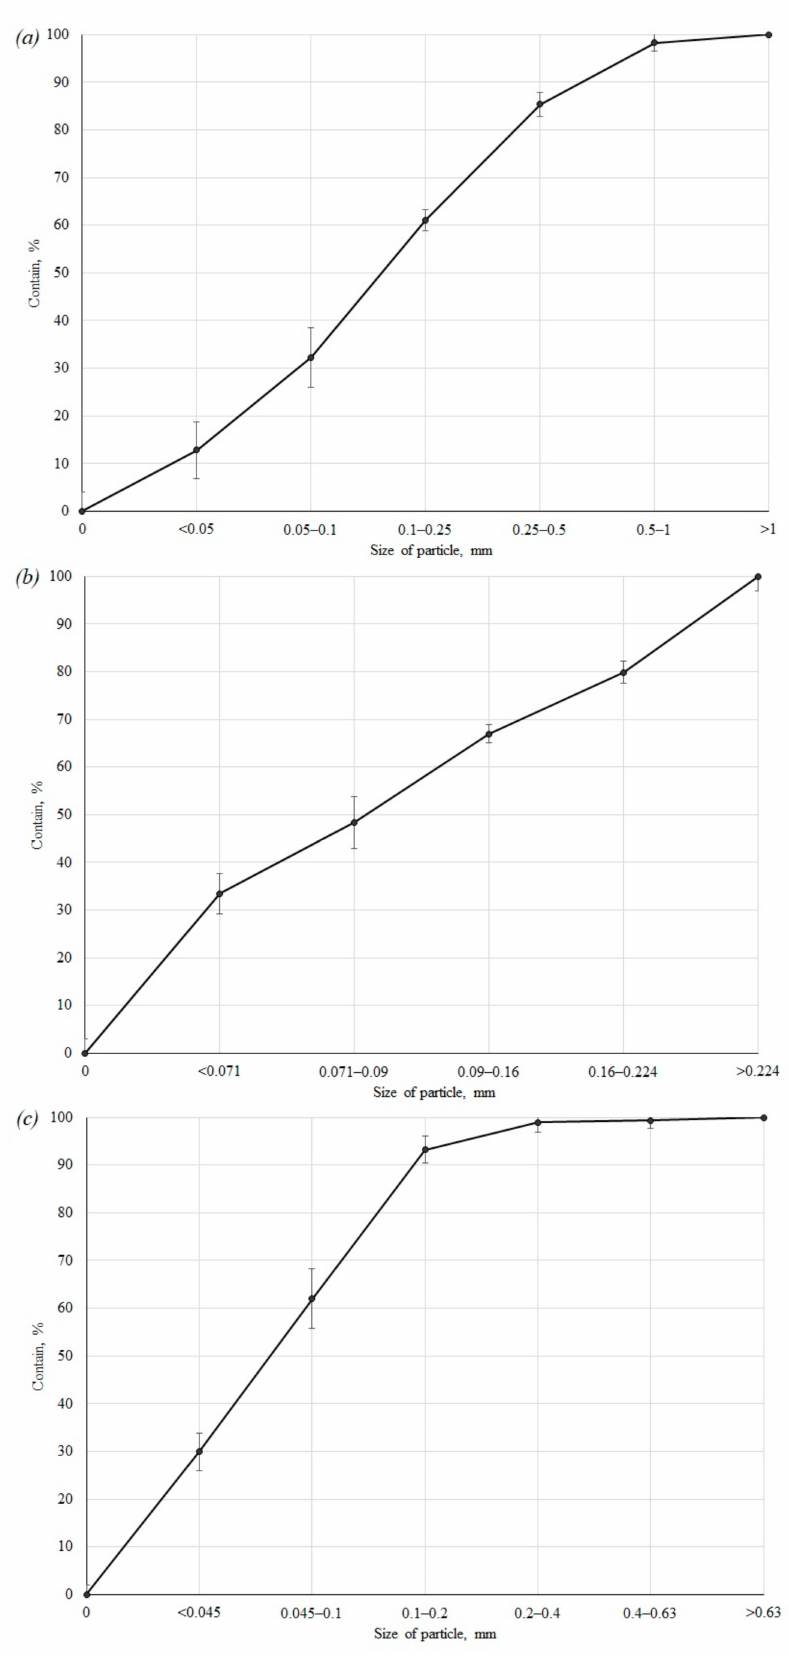
Figure 2. Cumulative curves of the granulometric composition: ( a )—loparite ore dressing tails, ( b )—apatite-nepheline ore dressing tails, ( c )—complex ore dressing